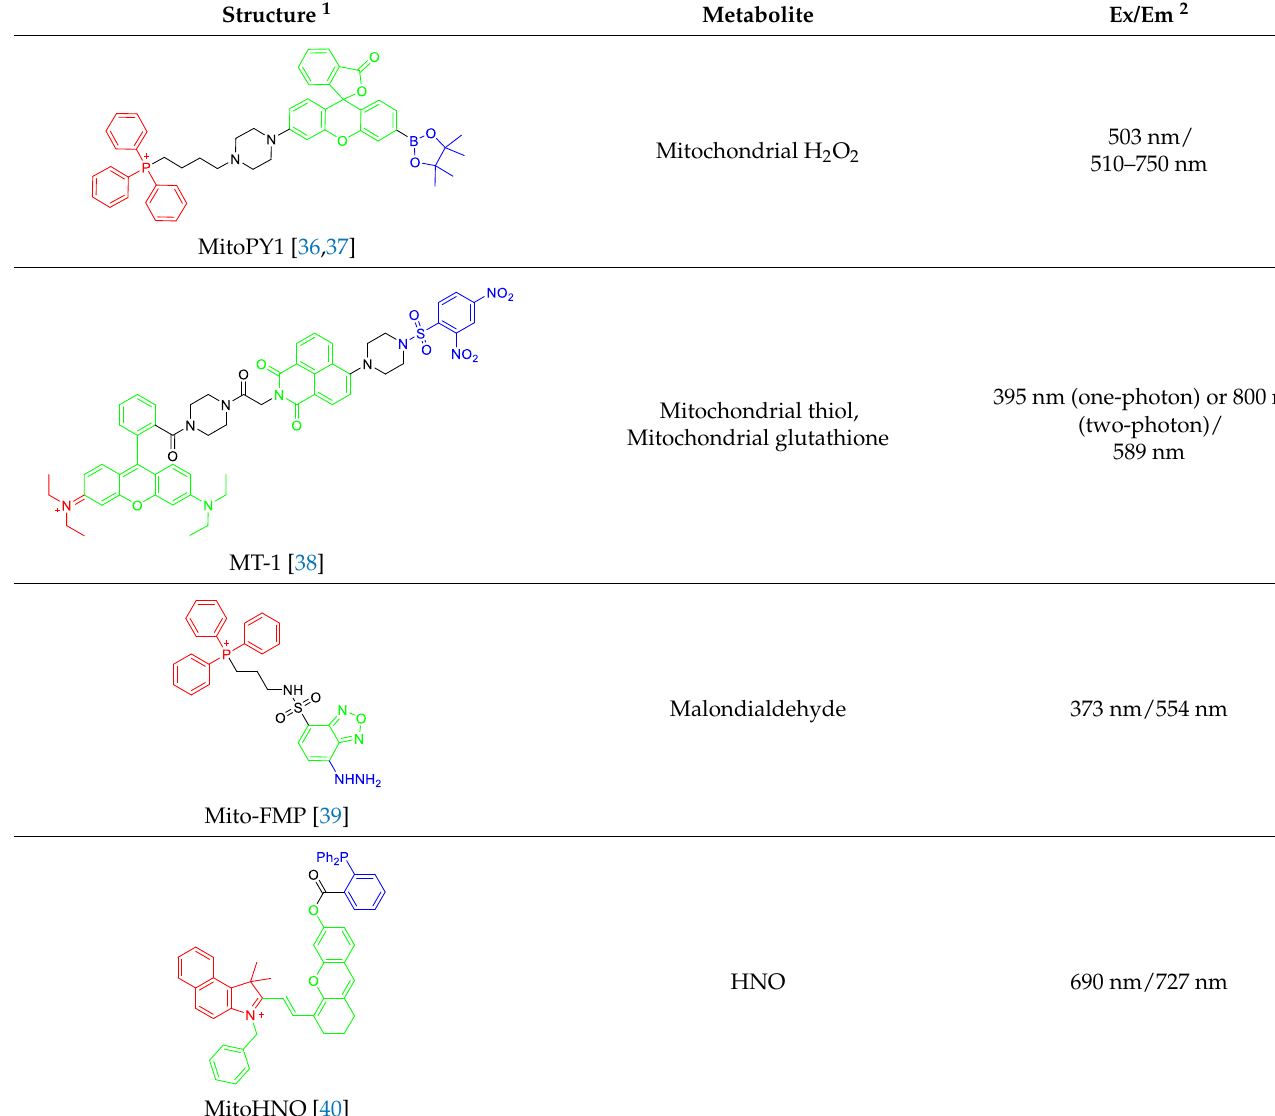
Table 1. Summary of the chemical probes for targeting various types of mitochondrial metabolites.